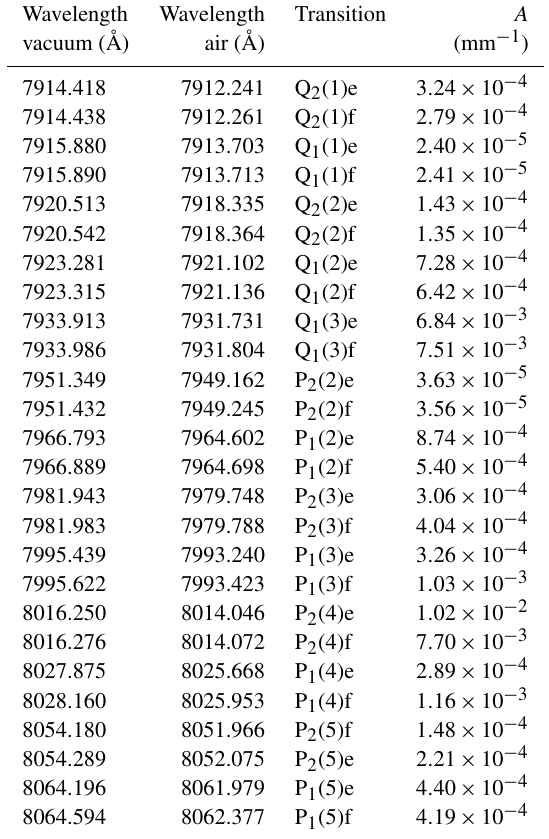
Table 2. Water vapour transmission at wavelengths of OH(5–1) lines. Vacuum wavelengths are from Rousselot et al. (2000), with conversion to air wavelengths undertaken as specified by Ciddor (1996). At each wavelength, water vapour transmission is given by a function of PWV: T λ = exp ( − A × PWV ) , with PWV in